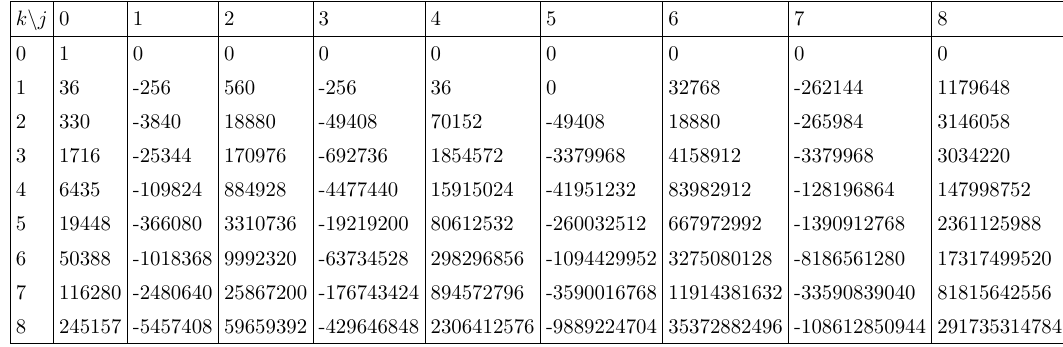
Table 36. Table of b jk coe(cid:14)cients for h Sp(4)